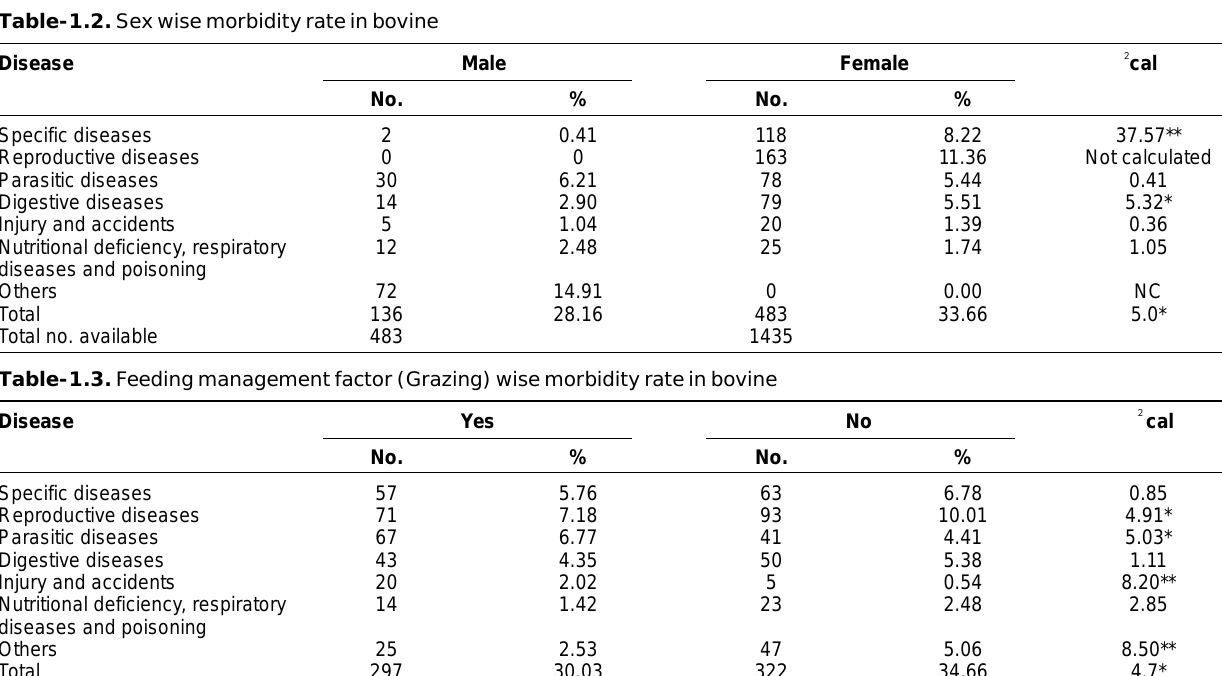
Specific diseases